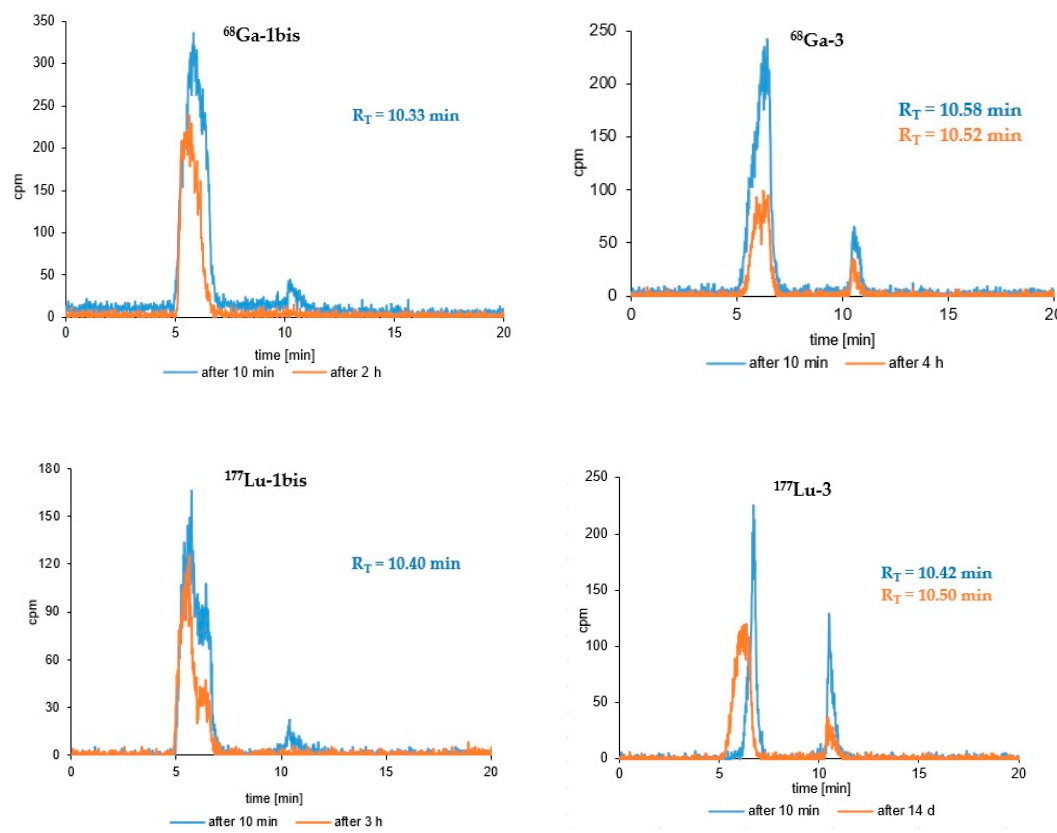
Figure 5. RP-HPLC radiochromatograms of human serum stability tests of the 68 Ga-1bis , 177 Lu-1bis , 68 Ga-3 and 177 Lu-3 (System 3) radioconjugates after different incubation times.